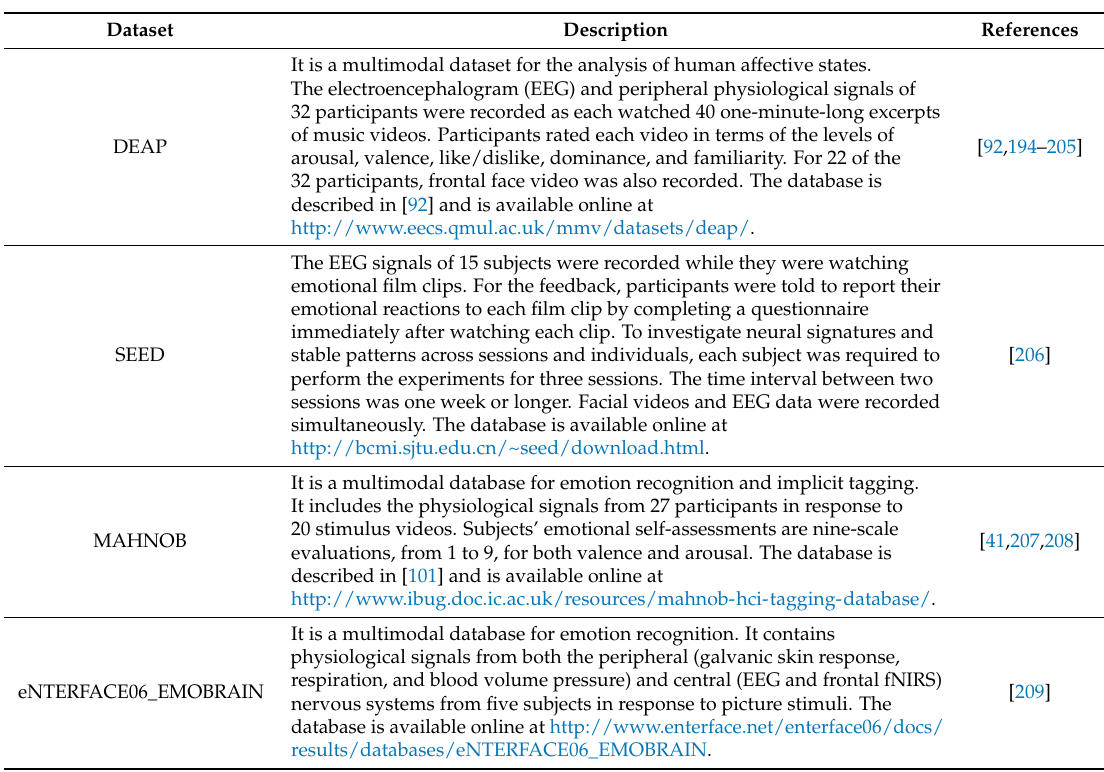
Table 4. Benchmark EEG emotional